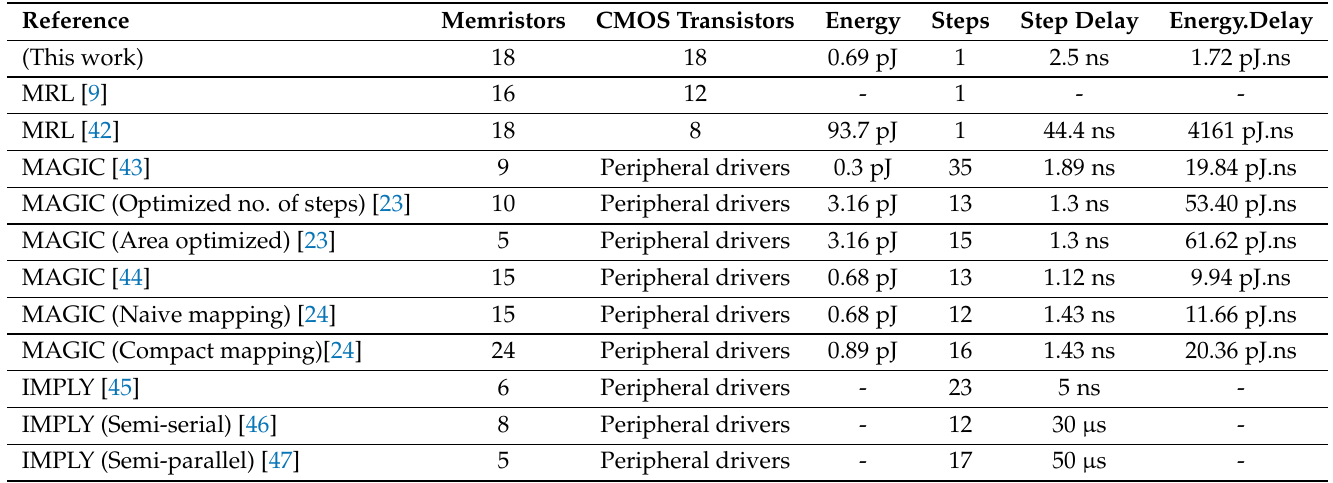
Table 3. Comparison with previous